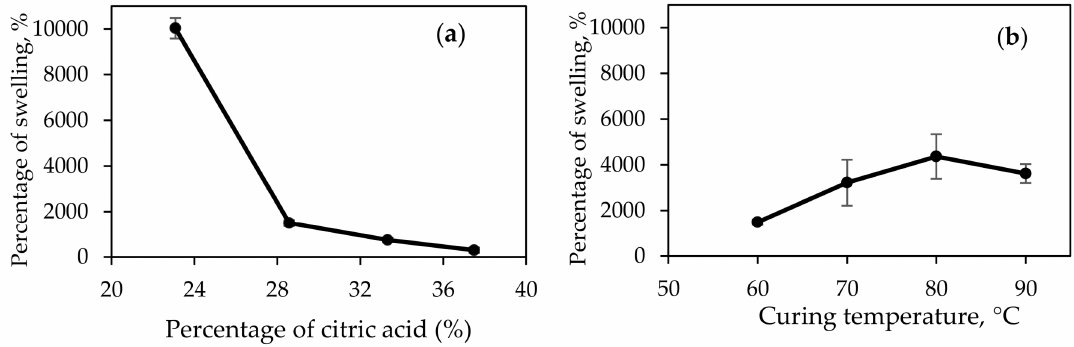
Figure 5. Plot of percentage of swelling at ( a ) di ff erent percentage of citric acid (23%, 29%, 33% and 38%) at fixed 60 ◦ C and 450 min of curing; and ( b ) di ff erent curing temperature (60 ◦ C, 70 ◦ C, 80 ◦ C and 90 ◦ C) but at fixed 29% citric acid, 450 min of curing.